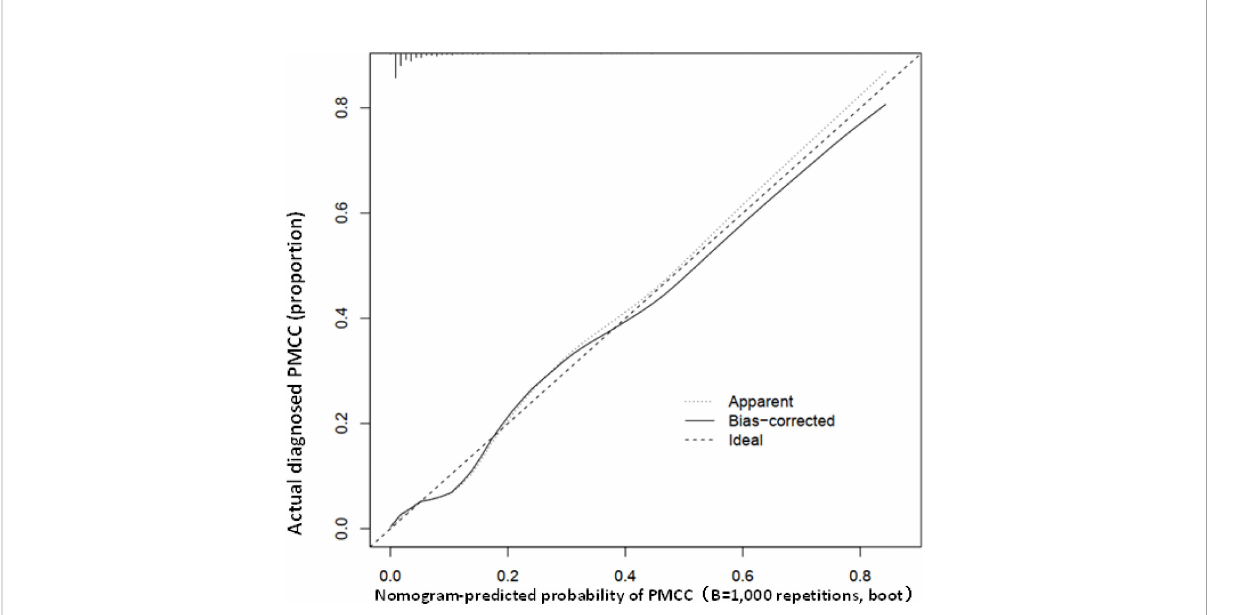
FIGURE 4 Receiver operating curve (ROC) of the